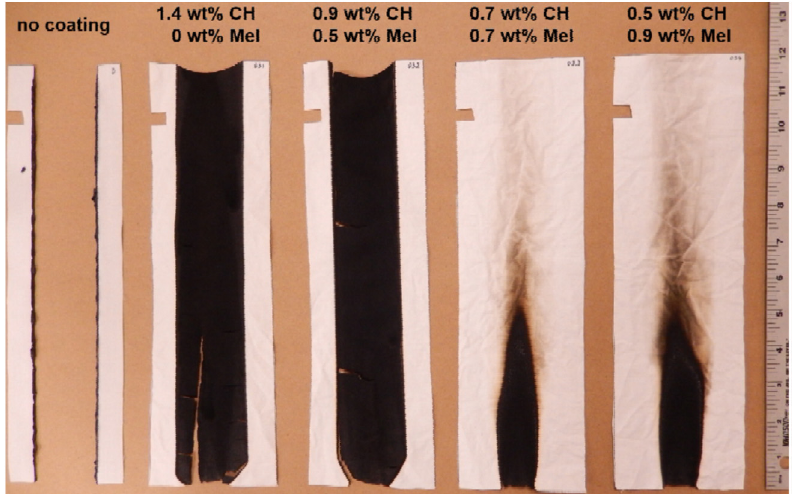
Figure 9. Results of VFT of CH/PSP coating on fabric with melamine addition [144] Reproduced with permission from Leistner, M.; Abu-Odeh, A.A.; Rohmer, S.C.; Grunlan, J.C., Carbohydr. Polym.; published by Elsevier Ltd., 2015.